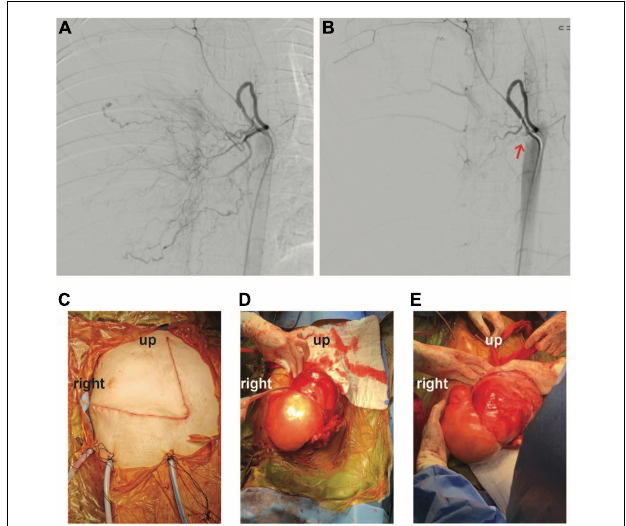
FIGURE 3 | Angiographic findings (A) before and (B) after embolization of tumor feeding vessels (coil indicated by red-arrow). (C–E) Intra-operative photo illustrating successful en bloc excision of tumor through a hemi-clamshell